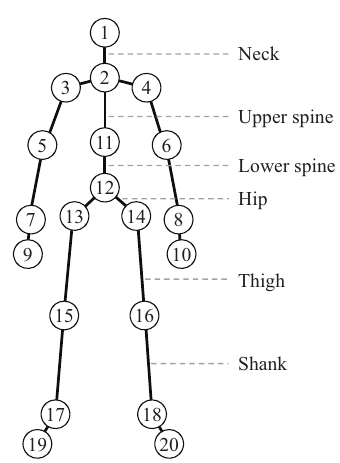
Figure 5. Three-dimensional human skeleton model consisting of 20 joints and 19